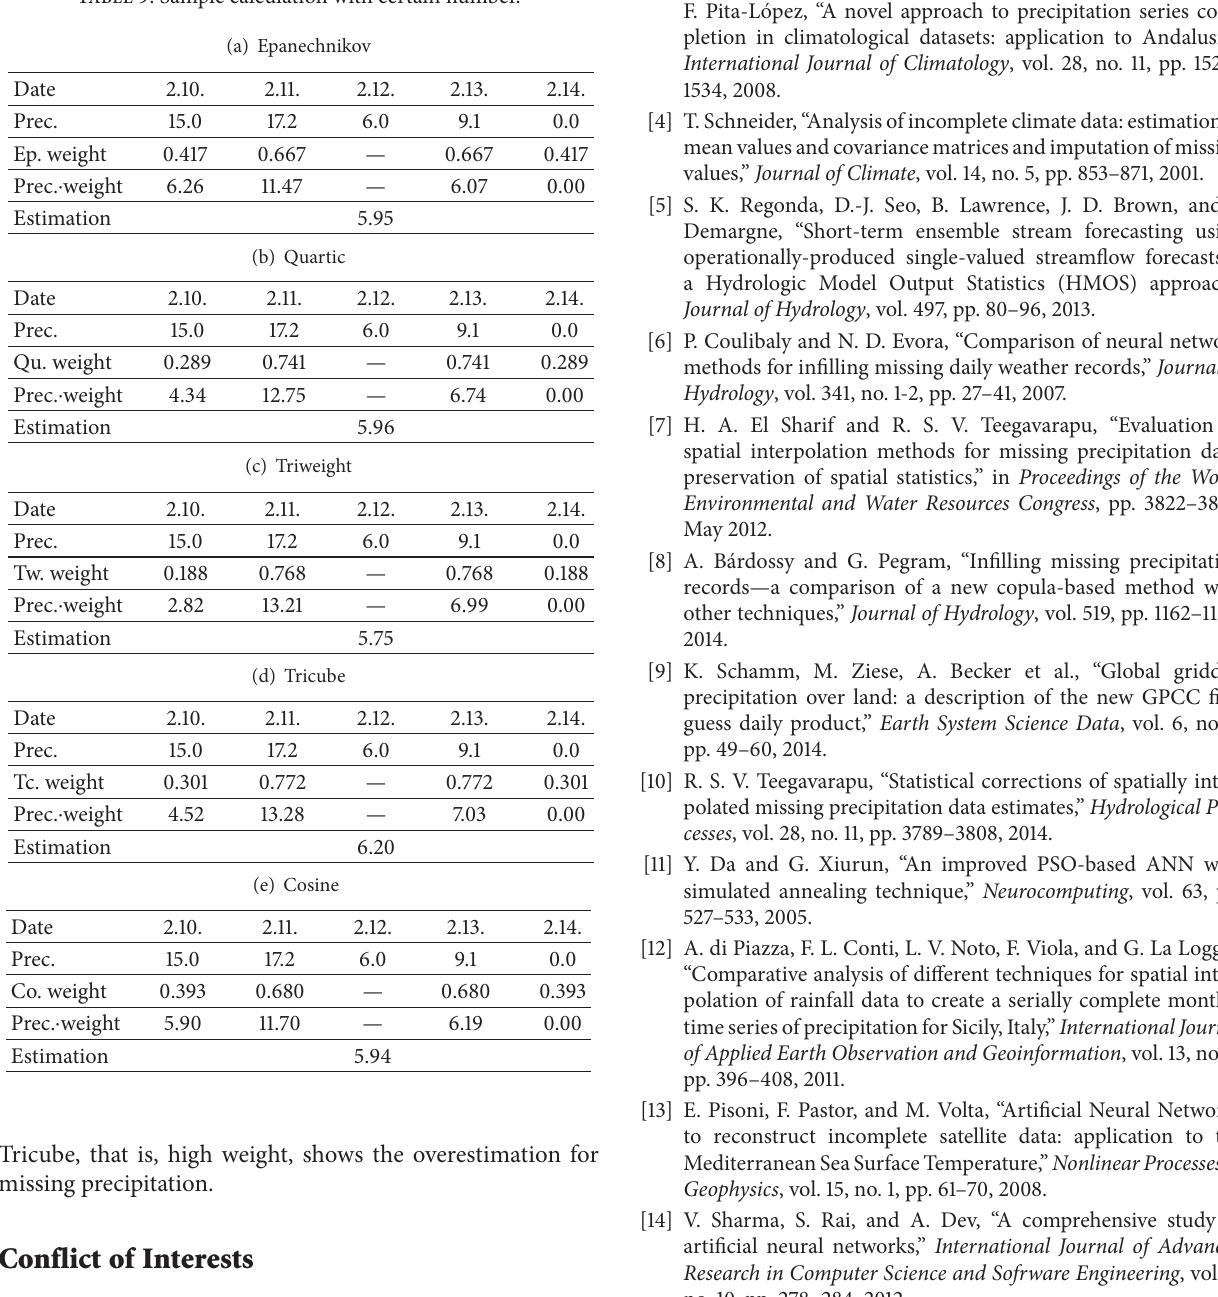
Table 9: Sample calculation with certain